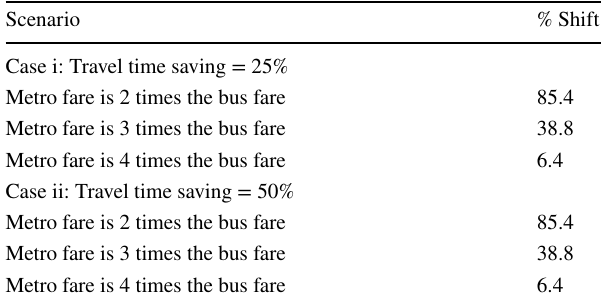
Table 9 Probability of shift to metro rail